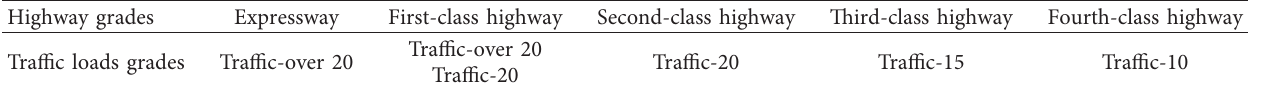
Table 1: Traffic load grades of the bridges in different highway grades in JTJ 021-89.